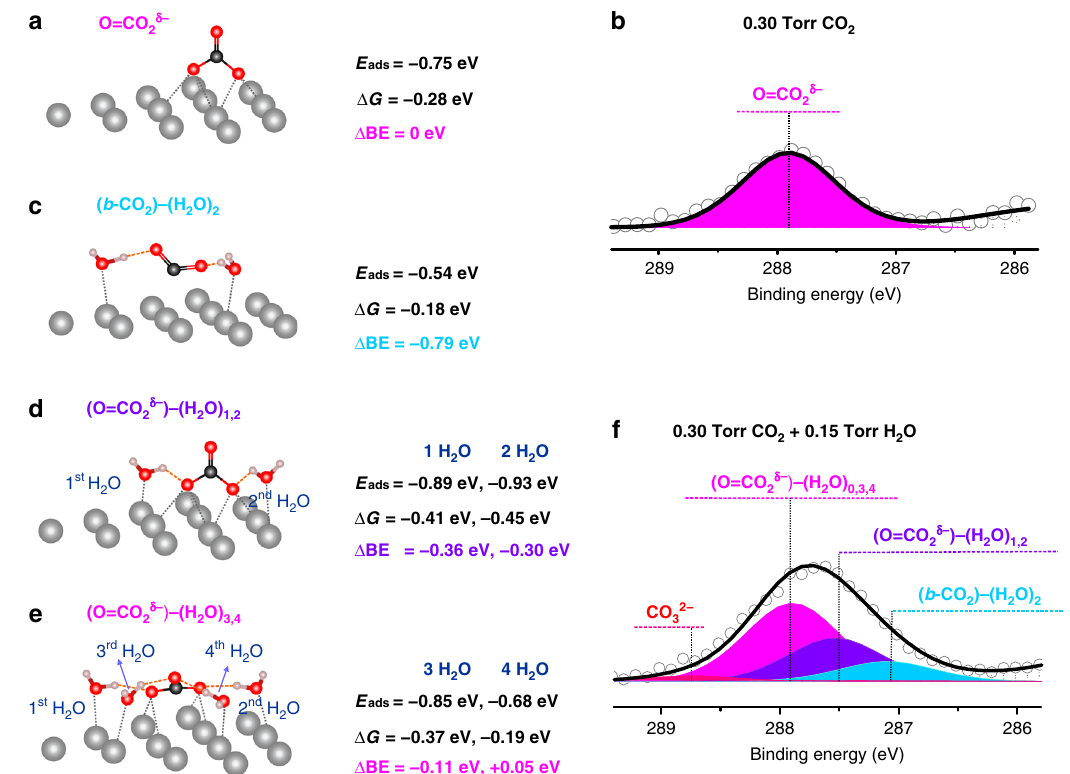
Fig. 2 The QM predictions and experimental observations of Ag surface with CO 2 adsorption alone and in the presence of H 2 O at 298 K. a Predicted structures for O = CO 2 δ − on Ag surface. The O = CO 2 δ − C 1s peak BE has been set as the reference point for subsequent experiments with H 2 O. b The C 1s APXPS spectra for Ag surfaces in the presence of 0.3 Torr CO 2 at 298 K. One single C 1 s peak representing O = CO 2 δ − was observed. c b- CO 2 becomes stabilized by a pair of H 2 O ad each forming a HB with an O of b- CO 2 , leading to Δ G of − 0.18 eV with respect to desorbing H 2 O and CO 2 . d , e The adsorbed O = CO 2 δ − species stabilizes one or two H 2 O ad via HBs to the O ad and two more water with HBs to the O up . O = CO 2 δ − stabilizes the 1st, 2nd, 3rd, and 4th H 2 O on this site with Δ G of − 0.41 eV, − 0.45 eV, − 0.37 eV, and − 0.19 eV, respectively. f The C 1 s APXPS spectra and the peak deconvolution results for Ag surfaces in the presence of 0.3 Torr CO 2 and 0.15 Torr H 2 O at 298 K. This deconvolution used the peak separations from the theory. The new surface adsorbates, (O = CO 2 δ − )-(H 2 O) 1,2 and ( b- CO 2 )-(H 2 O) 2 , are observed experimentally in the APXPS measurements, showing up as the two new peaks at 0.4 eV and 0.8 eV, lower than the O = CO 2 δ − peak. The species (O = CO 2 δ − ) – (H 2 O) 3,4 do not lead to additional peaks, because they are located at position that overlaps with that of O = CO 2 δ −